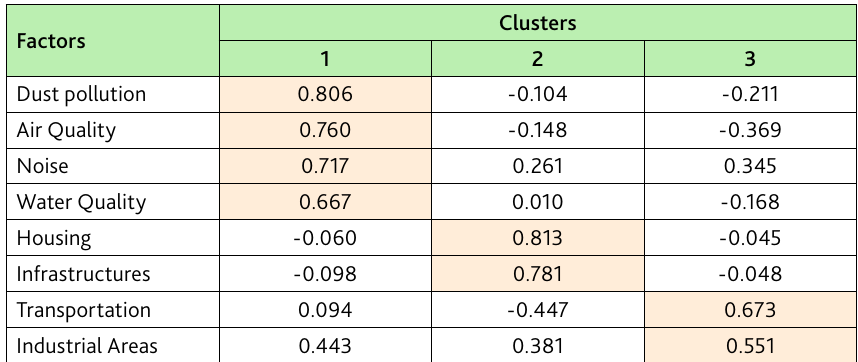
Table 1. Eigenvalues from successive extractions of principal components from built environment